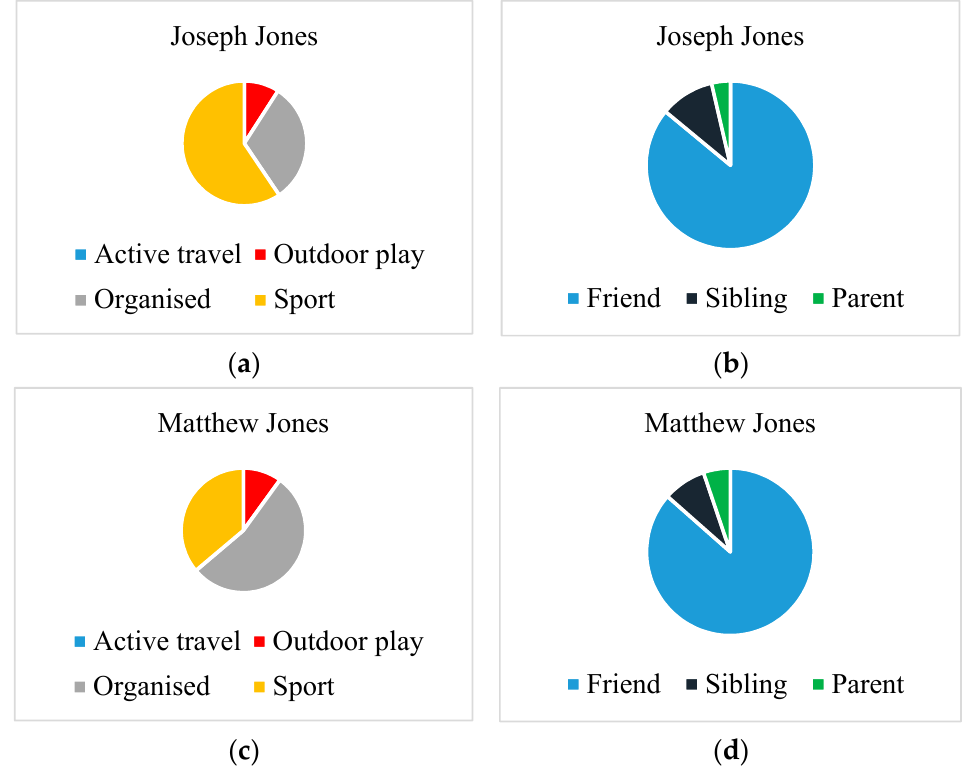
Figure 3. ( a , b ) PA diary data for Joseph Jones, and ( c , d ) PA diary data for Matthew Jones.